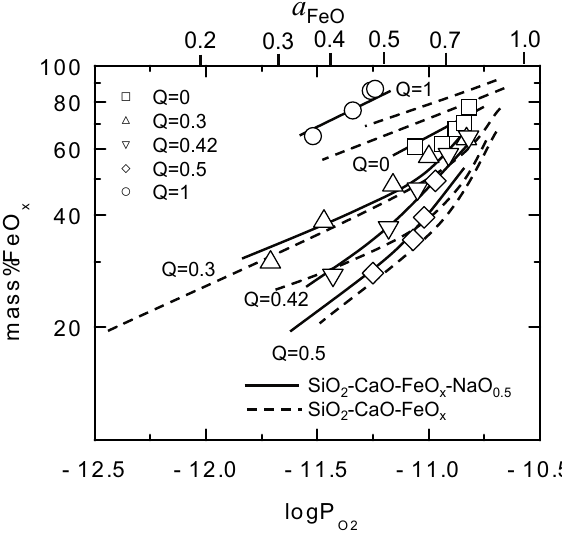
Figure 1. Iron oxide content in the FeO x -CaO-SiO 2 - NaO 0:5 slag as a function of the oxygen partial pressure with metallic iron saturation at 1573 K.